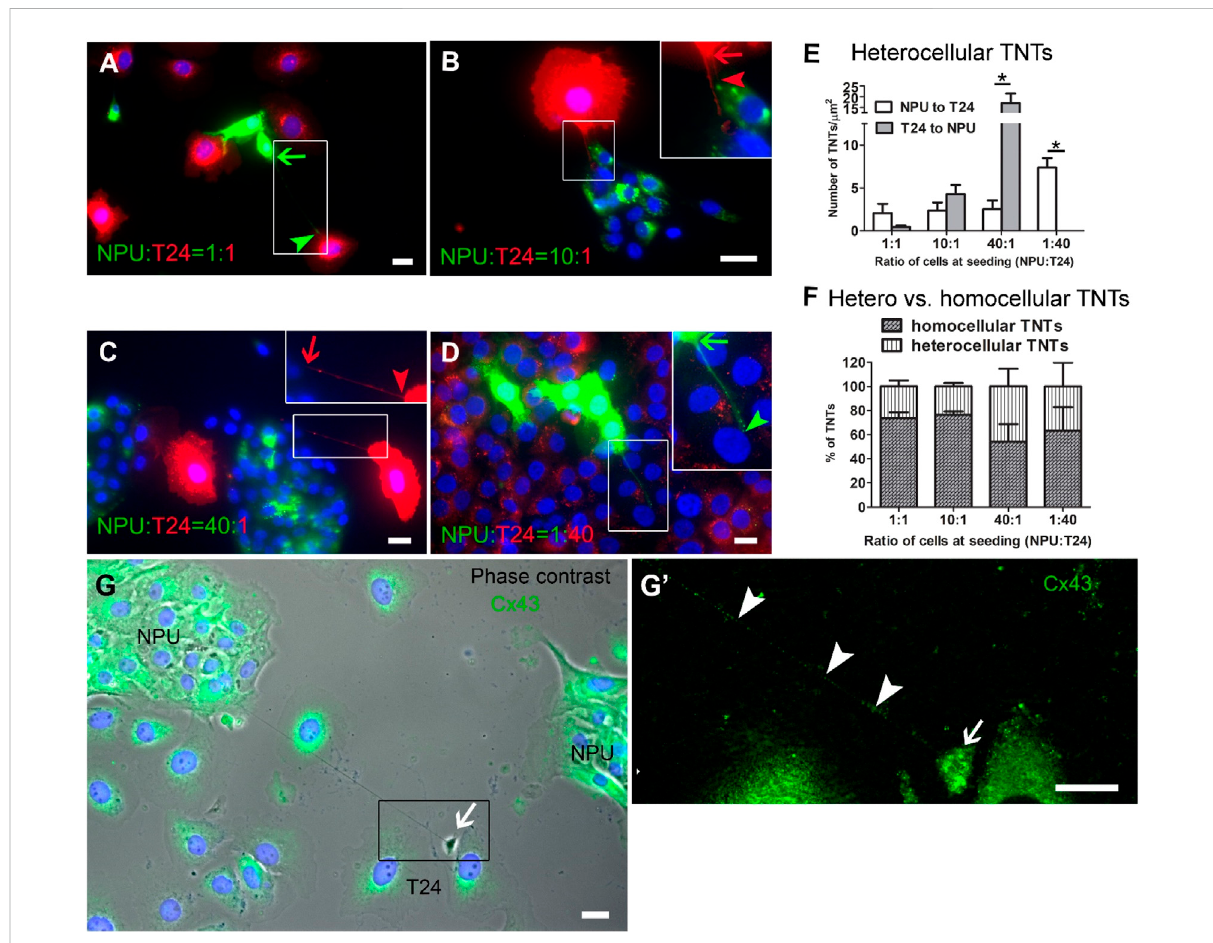
FIGURE 10 Normal urothelial (NPU) cells form TNTs to cancer urothelial (T24) cells and vice versa (A) TNTs are formed from DiO-labelled NPU cells to DiI- labelledT24cellsandfromDiI-labelledT24toDiO-labelledNPUcells.ArrowsdenotethebeginningsandarrowheadstheendsofTNTs.Thecolorof the arrow/arrowhead denotes the cell origin of the TNT. (A and B) When cells were seeded at 1:1 or 10:1 ratio (NPU cells: T24 cells), the number of TNTs from NPU to T24 cells is the same as the number of TNTs from T24 to NPU cells. (C and D) When cells were seeded at ahigher ratio (40:1 NPU:T24 cells), the number of TNTs of the cells in the minority was increased. (C) T24 cells in the minority formed signi fi cantly more TNTs to NPU cellsinthemajority (D) NPU cellsintheminorityformedsigni fi cantly more TNTsto T24cellsinthemajority. Nomixingofdyes wasdetected. (E) The number of heterocellular TNTs/cm 2 . At seeding ratio 1:40, no TNTs from T24 cells to NPU cells were detected. (F) The ratio (in %) between homocellularandheterocelluarTNTsinrelationtodifferentcocultures.Ratioofcells(NPU:T24)were1:1(5×10 3 :5×10 3 ),10:1(5×10 4 :1×10 3 ),40:1 (2×10 5 :5×10 3 )and1:40(5×10 3 :2×10 5 cells/cm 2 ).Fourindependentexperimentswereperformed,ineachthecellswereseededintriplicates.The entire surface with cells was imaged and all TNTs were counted. Values are expressed as mean ± SEM; * p < 0.05 . (G) Heterocellular TNT between NPU and T24 cell. Cx43 is present within TNT and at the end of TNT. ( G ’ ) The contact site is broad and enriched in Cx43. Scale bars: 20 μ